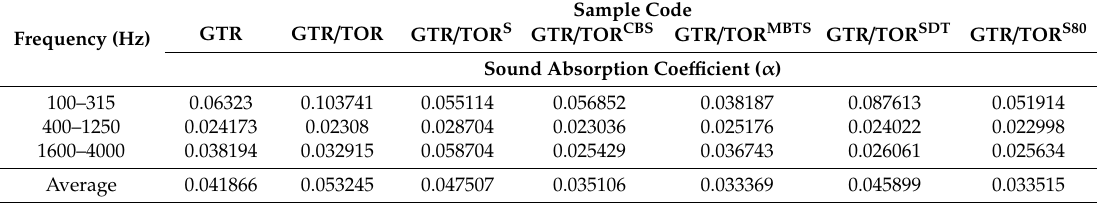
Table 8. The changes of the sound absorption coe ffi cient for the studied samples at low, medium and high frequencies.